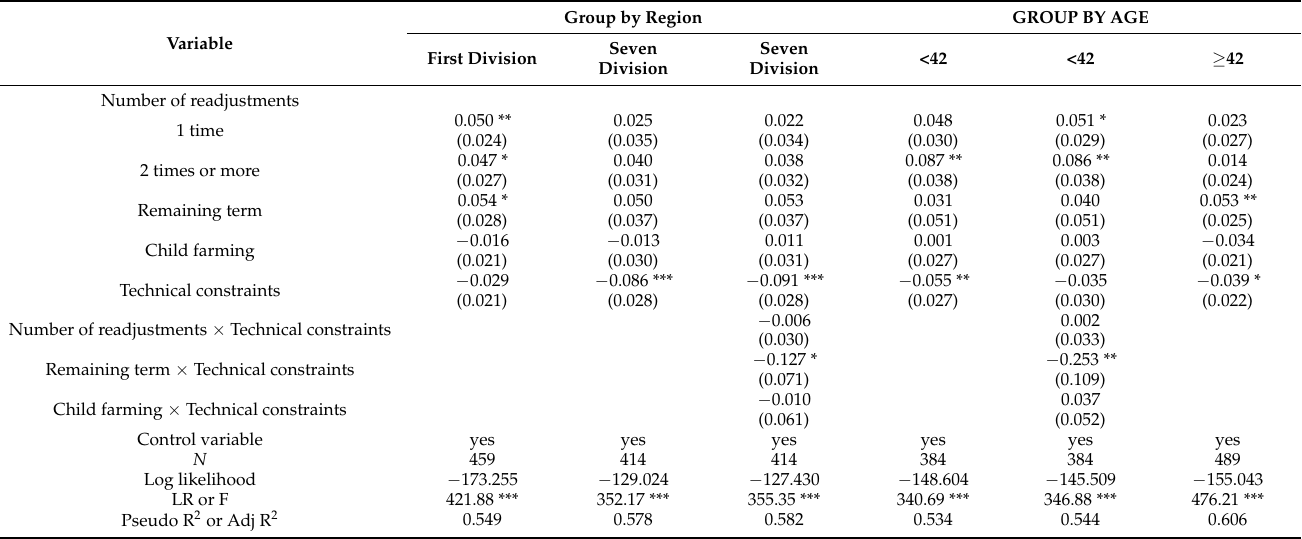
Table 6. Heterogeneity